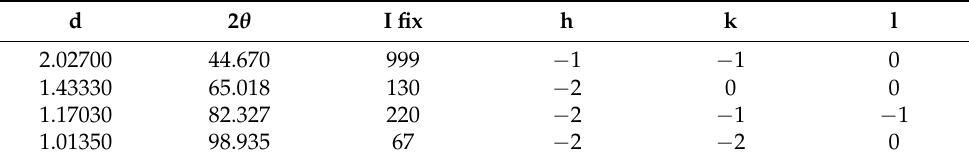
Table 1. XRD data of the synthesized nZVI at the optimum